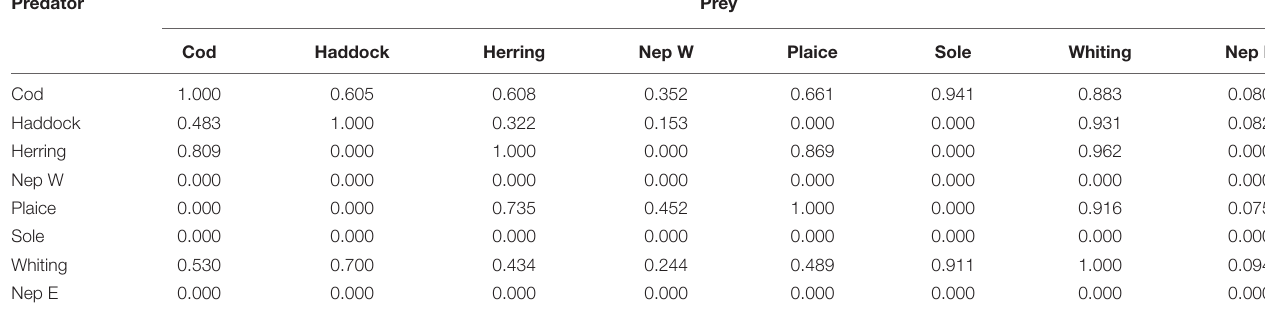
TABLE 3 | Irish Sea LeMans interaction matrix. Predator